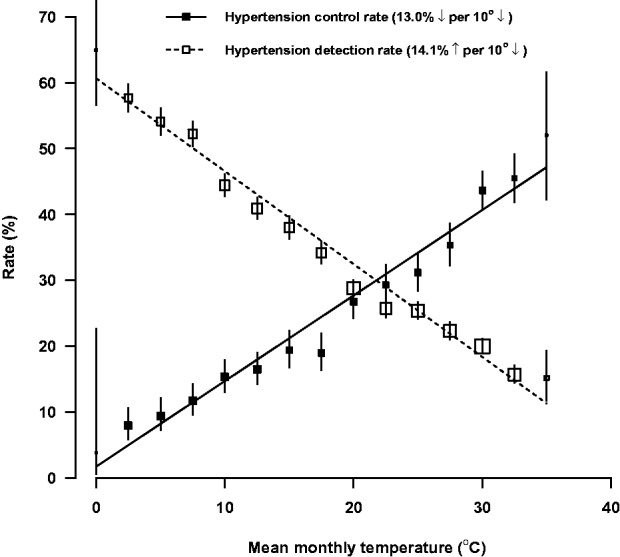
Detection and control rates of hypertension in relation to mean monthly outdoor temperature. Rates were adjusted for age, sex and education. The detection/control rates and 95% CIs are shown in open/solid squares and vertical lines. Sizes of squares are inversely proportional to the standard errors of the point estimates.